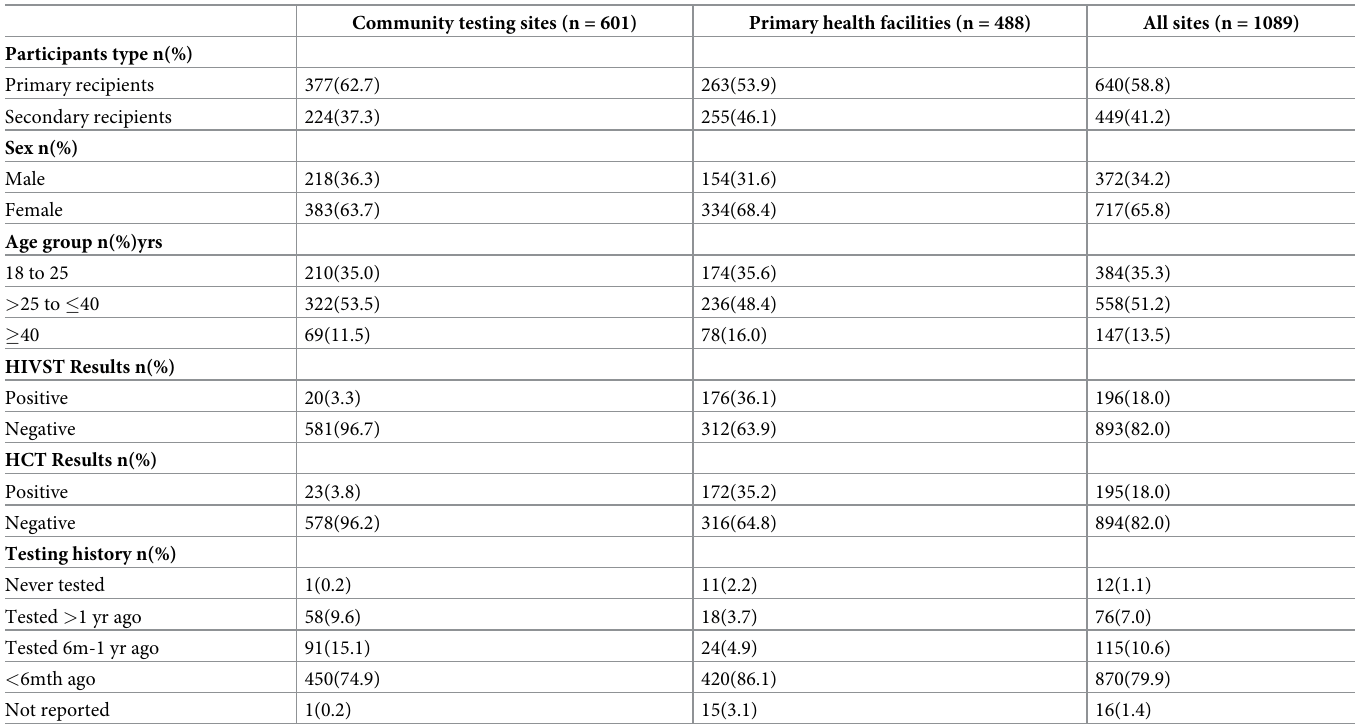
Table 3. Characteristics of HIVST users coming to the facility to perform HIV